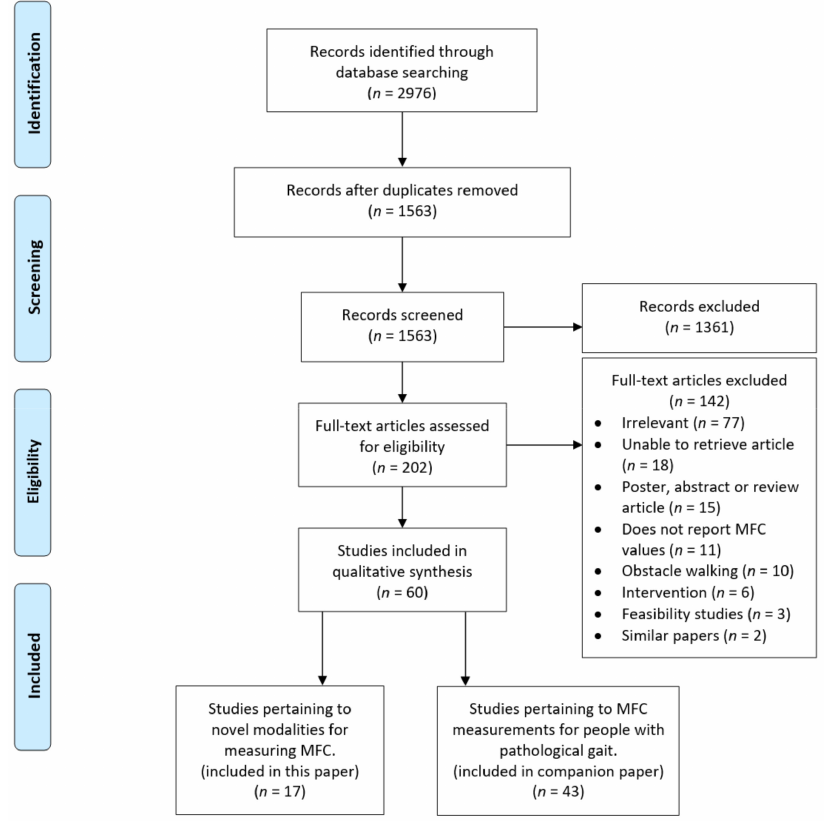
Figure 2. The flowchart of review